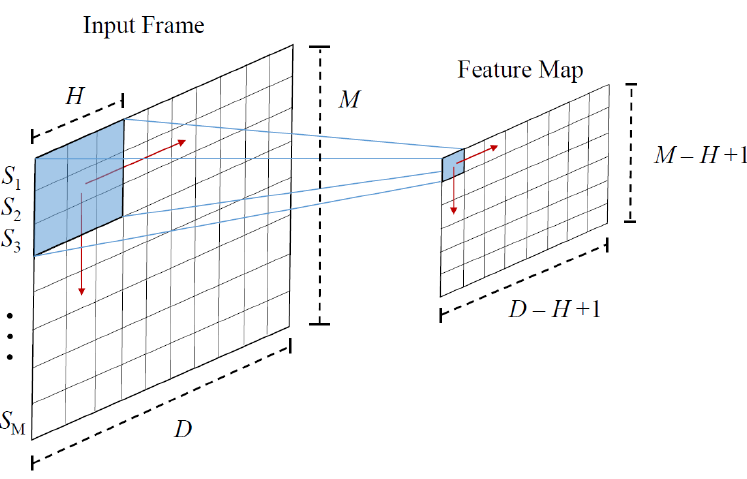
Figure 1. Application of 2-D convolutional filters to extract feature